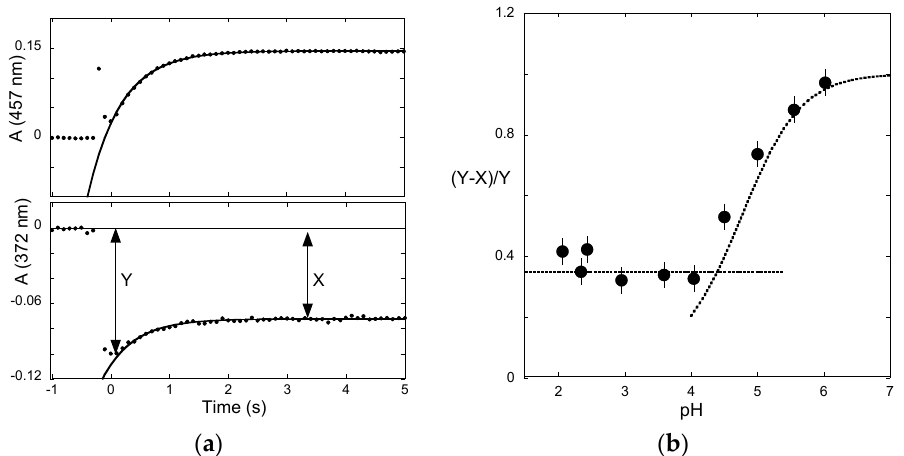
Figure 3. ( a ) Flash photolysis traces after a light flash at pH = 4.04.; ( b ) Ratio (Y − X)/Y corresponding to the efficiency of the back reaction as a function of pH. A global fitting was carried out using the data from Figures 1 to 3.